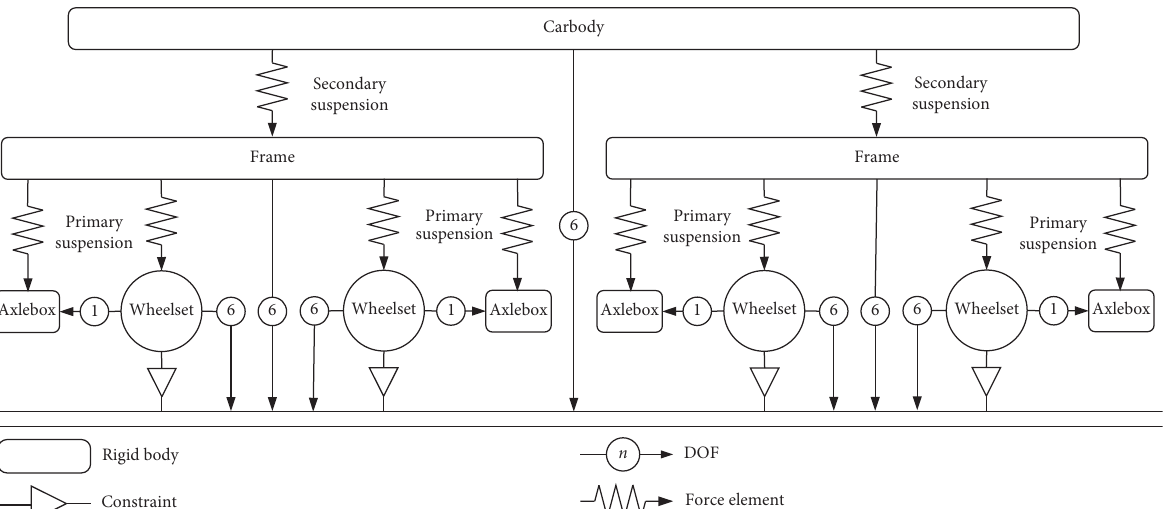
Figure 11: Topology model of metro vehicle.